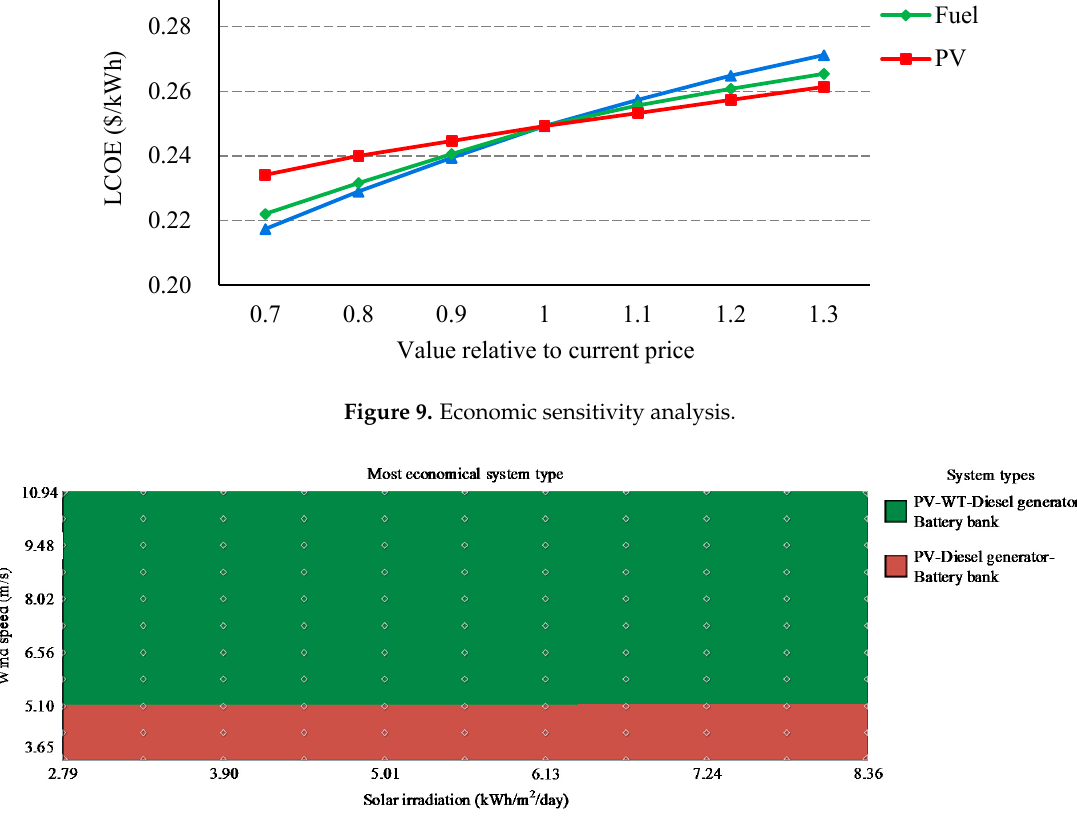
Figure 9. Economic sensitivity analysis.